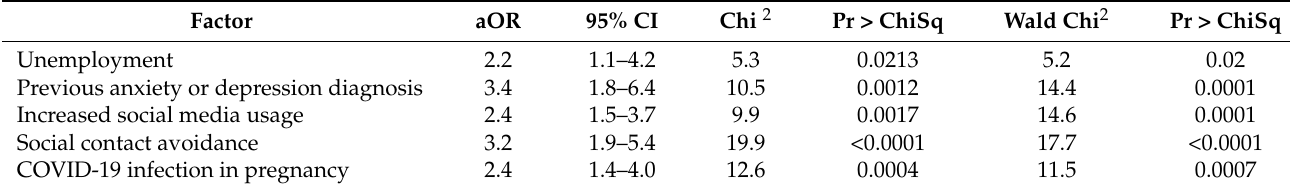
Table 6. Logistic regression analysis of factors influencing the severity of anxiety